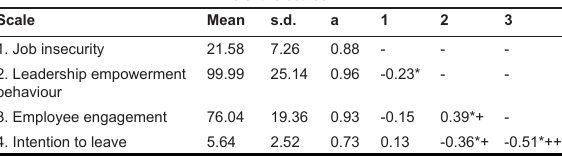
Descriptive statistics, alpha coefficients, and product-moment correlation